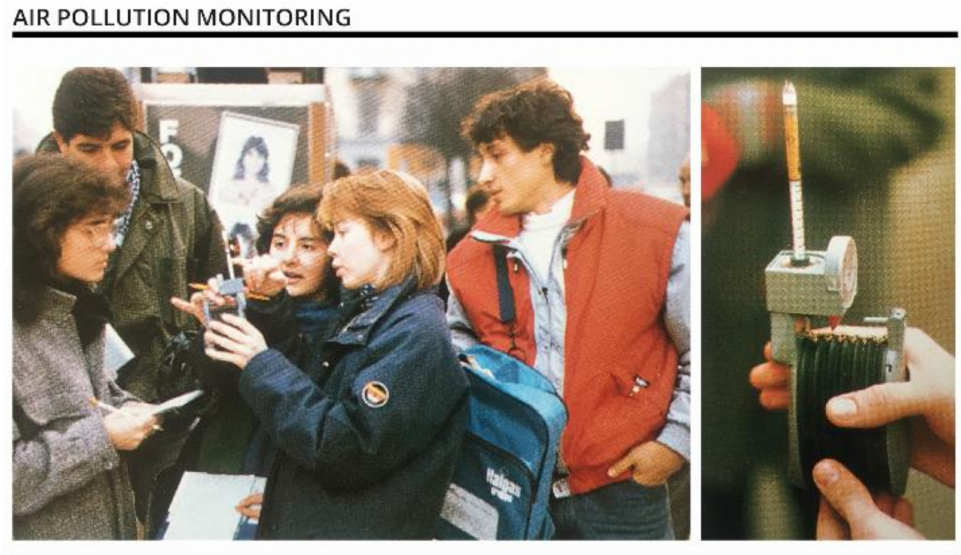
Figure 4. Air pollution monitoring: adolescents, there as researchers, measuring the concentrations of polluting gases in the air of the city where they live. They used a hand-held tool (enlarged image on the right), a 100 cc manual Dräger sampling system equipped with single-gas